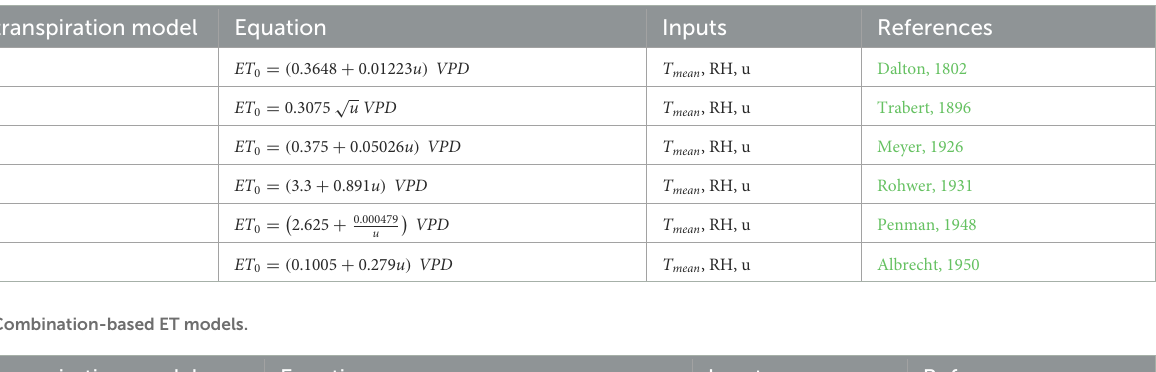
TABLE 3 Mass-transfer based ET 0 models.